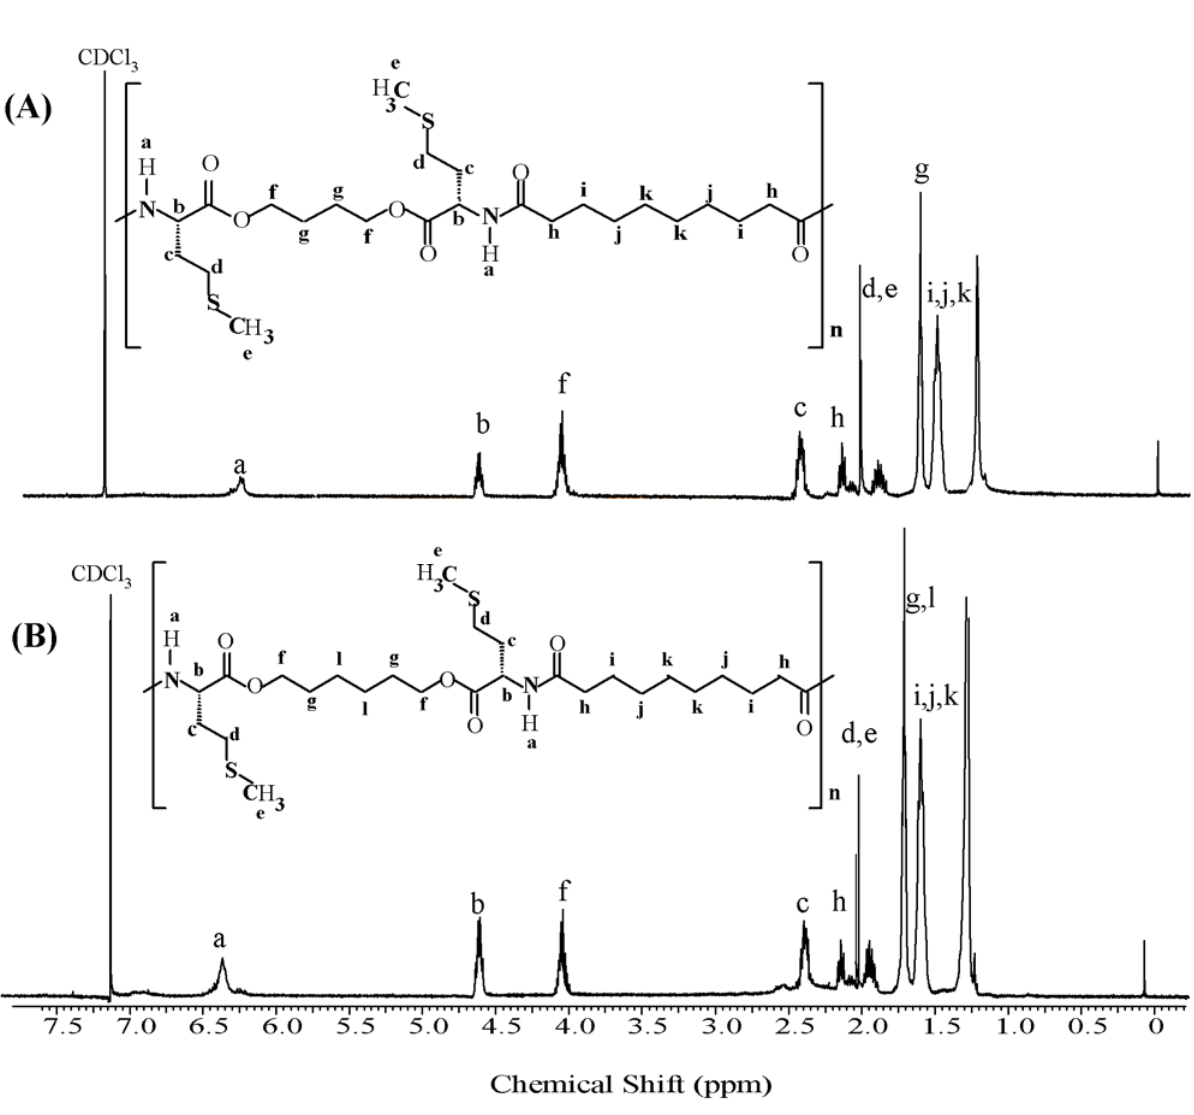
Figure 3. 1 H - NMR spectra for PEAs synthesized from L -methionine. (A) PEA-Me48 and (B)